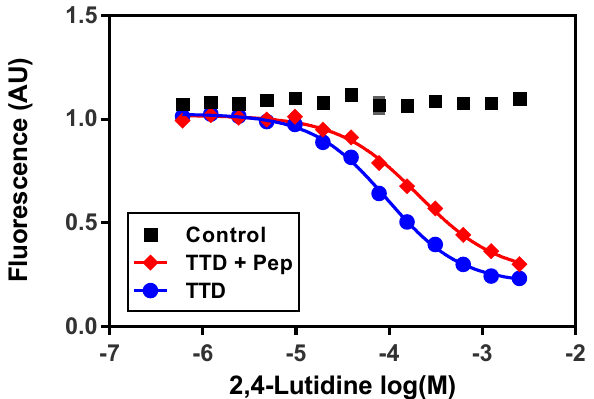
Figure 5. Tryptophan fluorescence monitors 2,4-lutidine binding to TTD. 2,4-Lutidine dose-dependently quenched the tryptophan fluorescence of TTD (blue circle), and adding H3K9me3 (1–20) peptide to twofold final TTD concentration (red diamond) shift the apparent K d of 2,4-lutidine binding from 98.2 ± 3.0 to 237.3 ± 11.4 µM (shown as K d ± S.E.M). 2,4-Lutidine did not inhibit the tryptophan fluorescence of control protein (black square, His-USP7-UBL1/2). n = 3 for each data point. Note : the standard deviation error bars are included, but the error values are often extremely small in this assay.